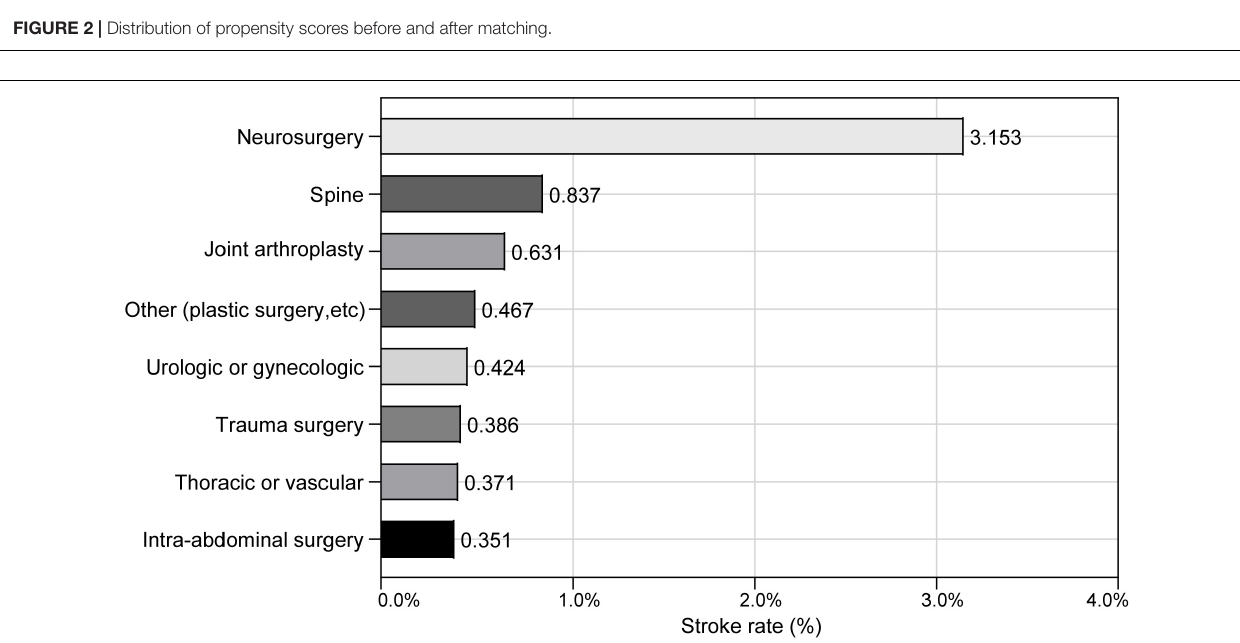
FIGURE 3 | Incidence of perioperative ischemic stroke among the different surgical